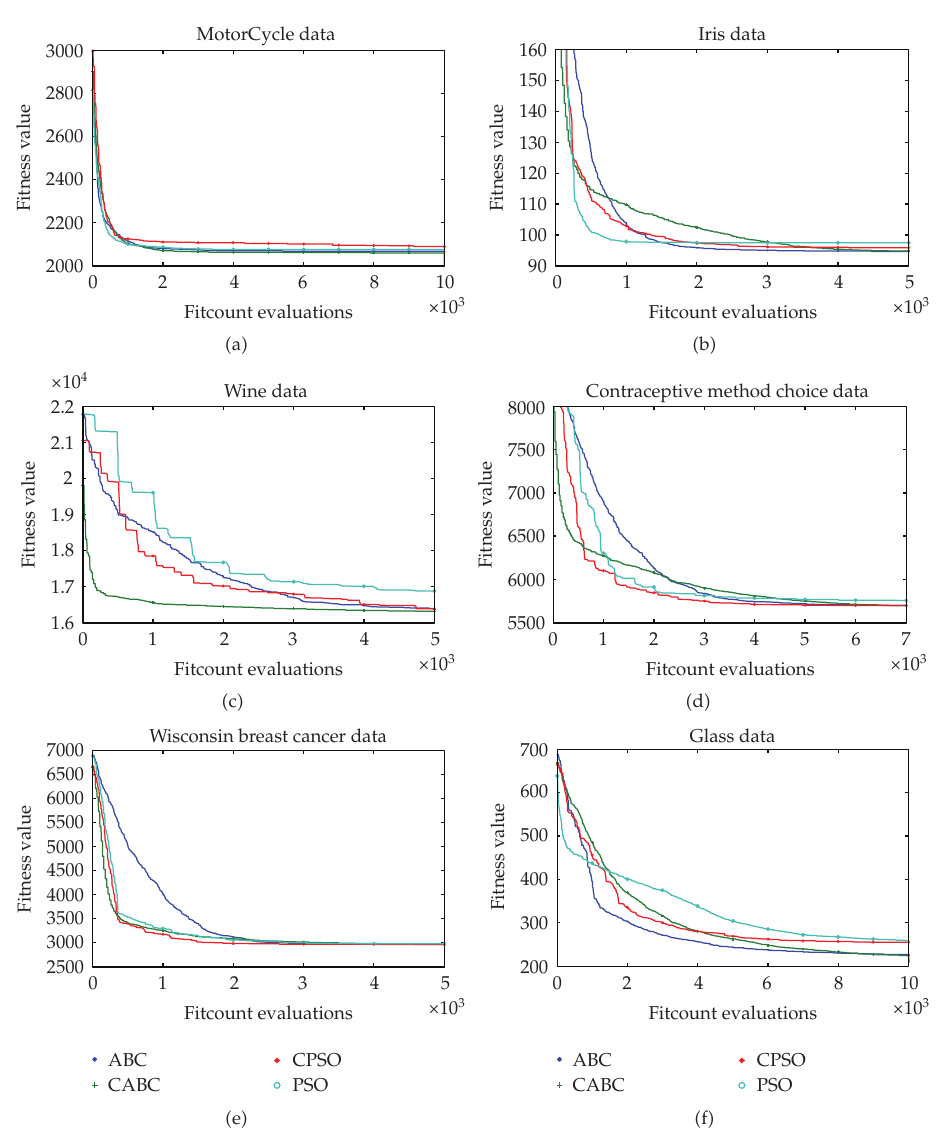
Figure 2: Comparing the convergence of the proposed CABC-based clustering with other approaches in terms of total mean-square quantization error (cid:2) a (cid:3) MotorCycle (cid:2) b (cid:3) Iris. (cid:2) c (cid:3) Wine. (cid:2) d (cid:3) CMC. (cid:2) e (cid:3) Cancer. (cid:2) f (cid:3)